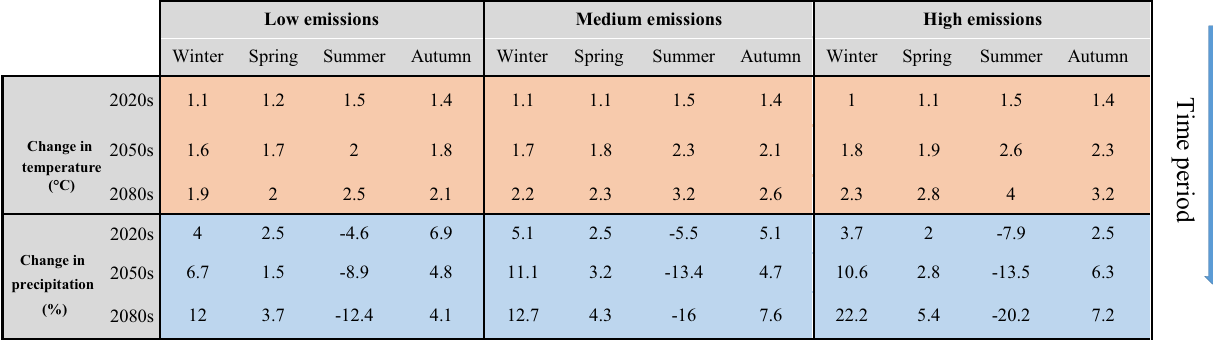
Table 1 Projected changes in temperature and precipitation, compared to 1961–1990 baseline, derived from joint probability data of UKCP09 climate change scenarios under low, medium and high emission scenarios for the 2020s, 2050s and 2080s (30-years’ time